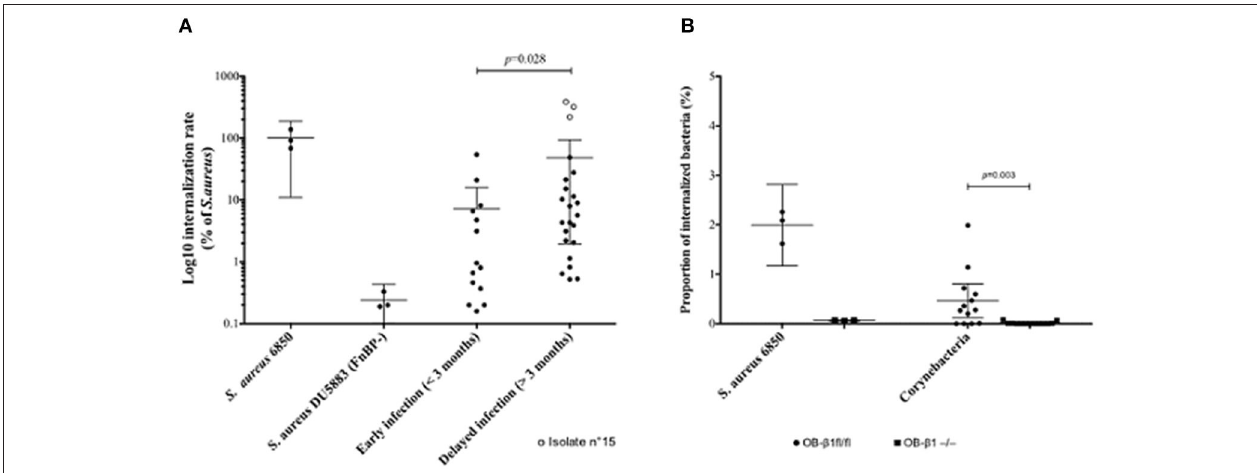
FIGURE 3 | Ability of Corynebacterium spp. isolates to invade osteoblastic cells. (A) Internalization rates of Corynebacterium isolates in MG63 human osteoblasts according to bone and joint infection (BJI) evolution delay, in comparison with S. aureus 6850 (positive control) and S. aureus DU5883 strain, inactivated for the fnbA/B genes (FnBP, negative control). (B) Internalization rates of the Corynebacterium isolates in murine osteoblasts with functional (OB- β 1 fl / fl ) or deficient (OB- β 1 − / − ) expression of the integrin β 1 subunit, in comparison with S. aureus